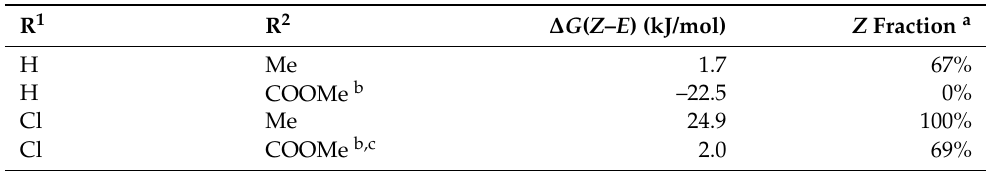
Figure 8. Model systems used to investigate the ( E , Z) isomerism of 1 . Table 5. Free energy difference between Z and E isomers of the pro-systems, calculated at the ω B97M-D4/cc-pVTZ level.